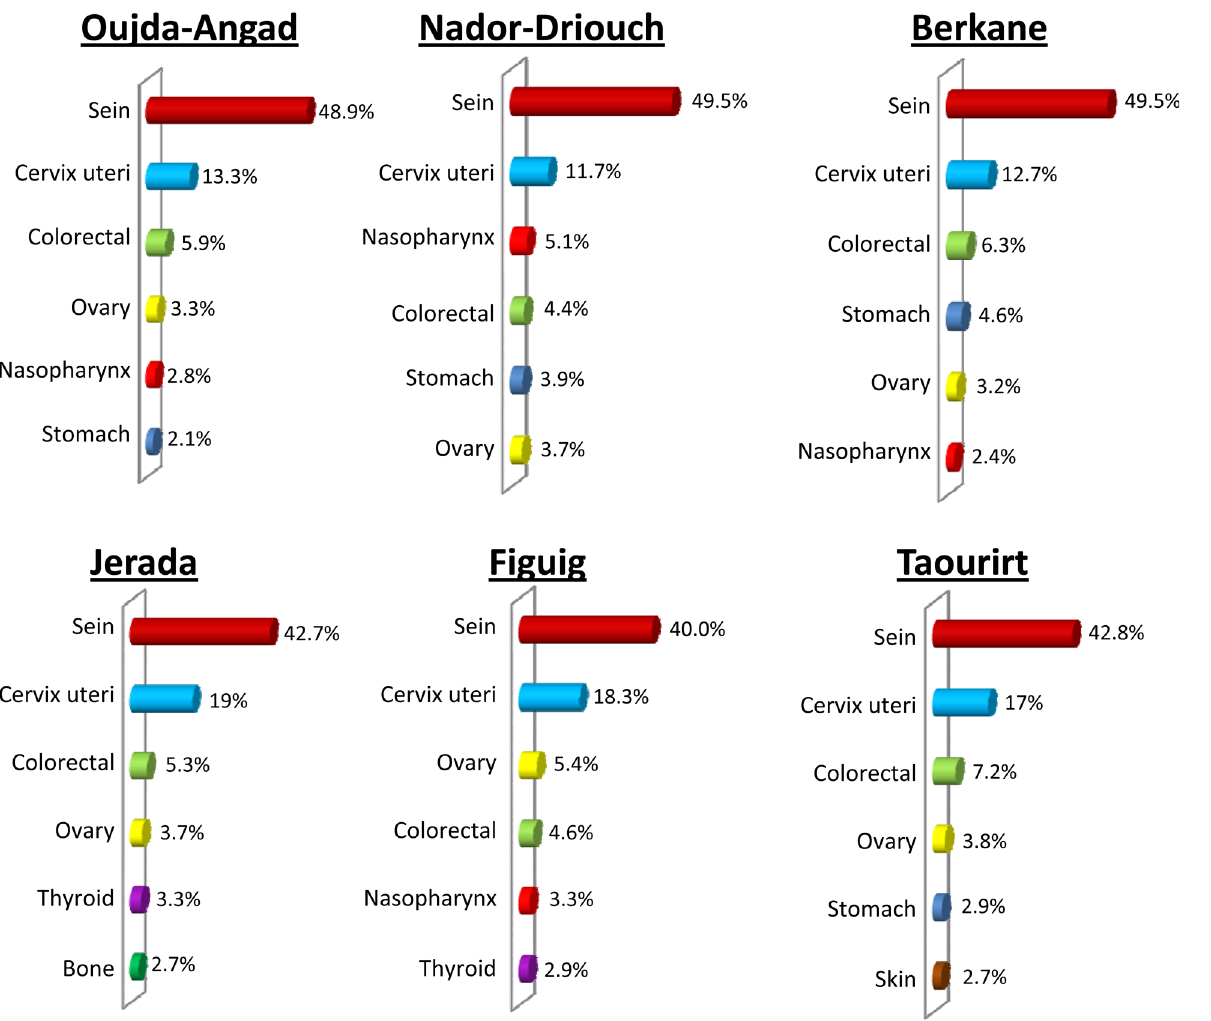
Fig 3. Distribution pattern of major cancer sites in females by area of Eastern Morocco, October 2005 – December 2012.